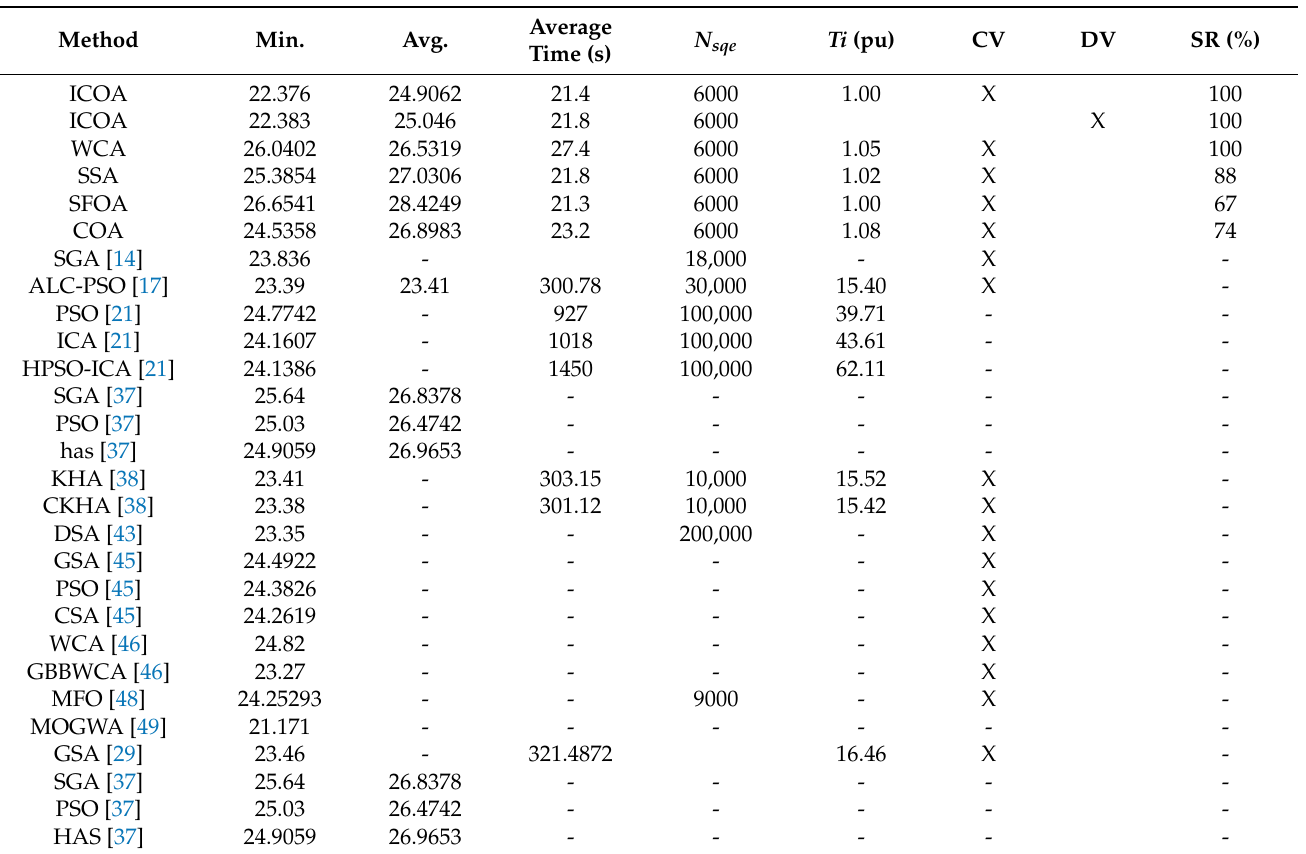
Table 8. Result comparison of TPL for the IEEE 57-bus